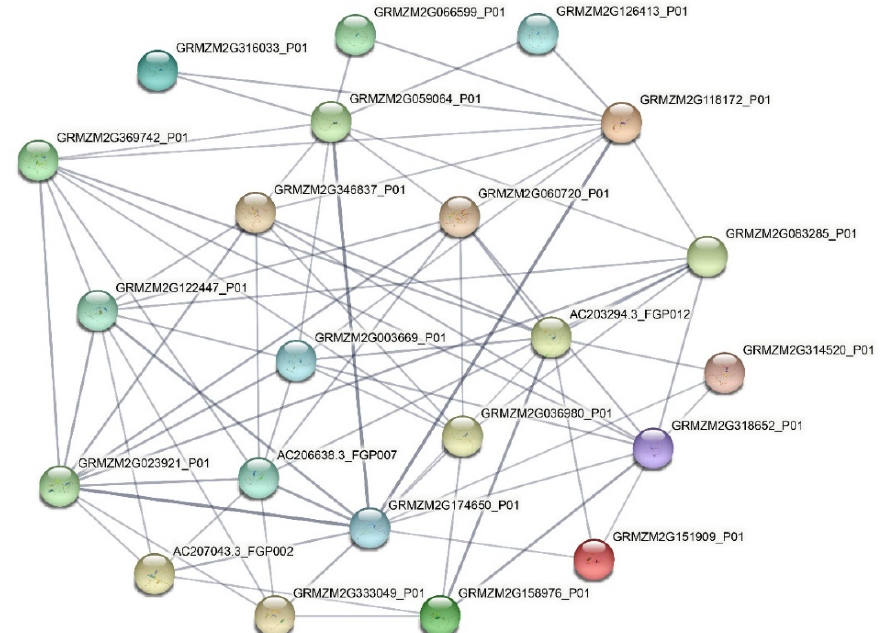
Figure 6. Schematic representation of protein–protein interaction (PPI) networks of the SsVQ proteins based on their orthologs in maize. The detailed information of the network is shown in Table S5. Gray lines connect proteins within the PPI networks with darker colors and thicker lines indicating higher core PPI values.